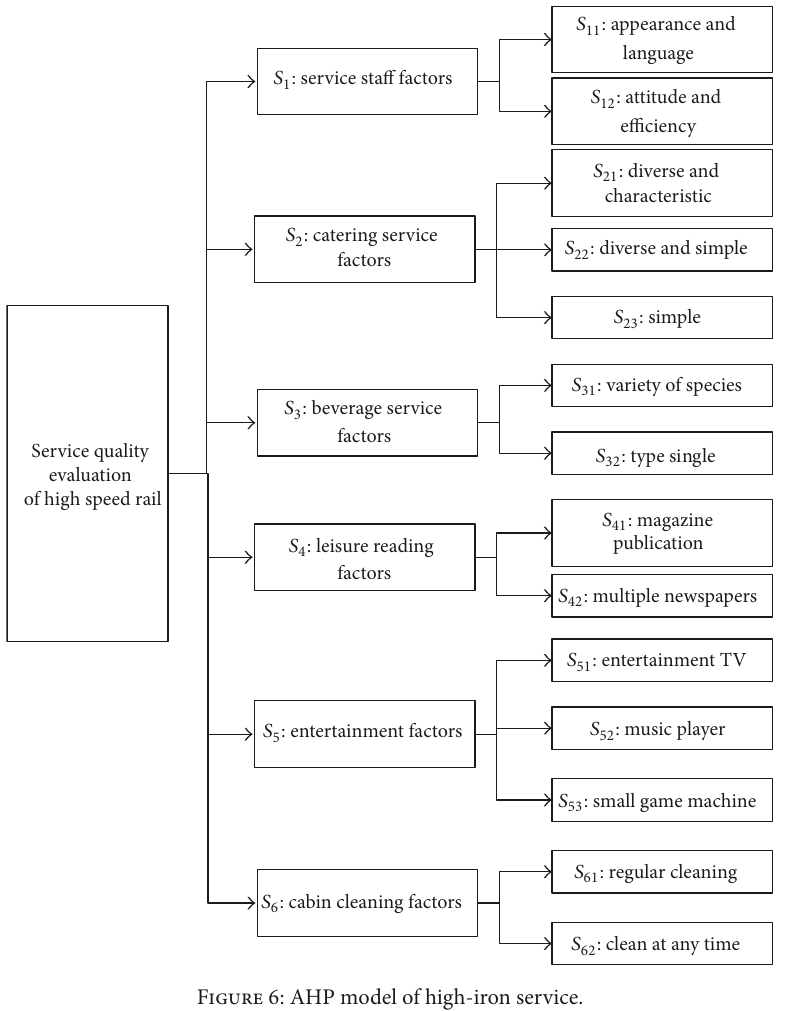
Figure 6: AHP model of high-iron